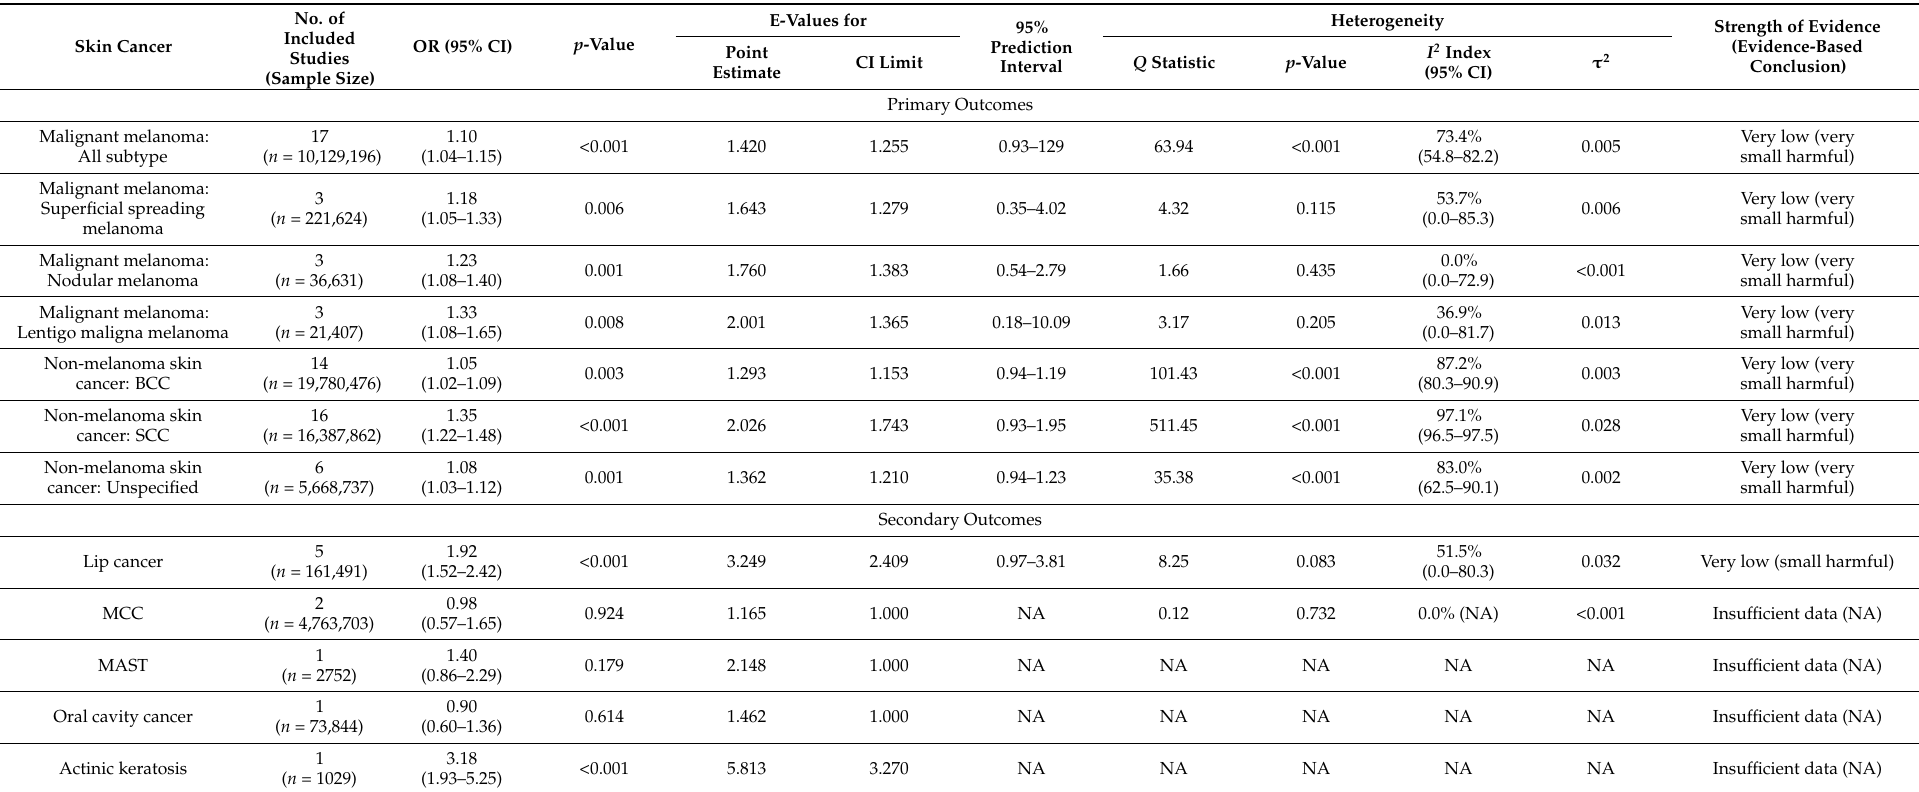
Table 2. Summary of findings and strength of